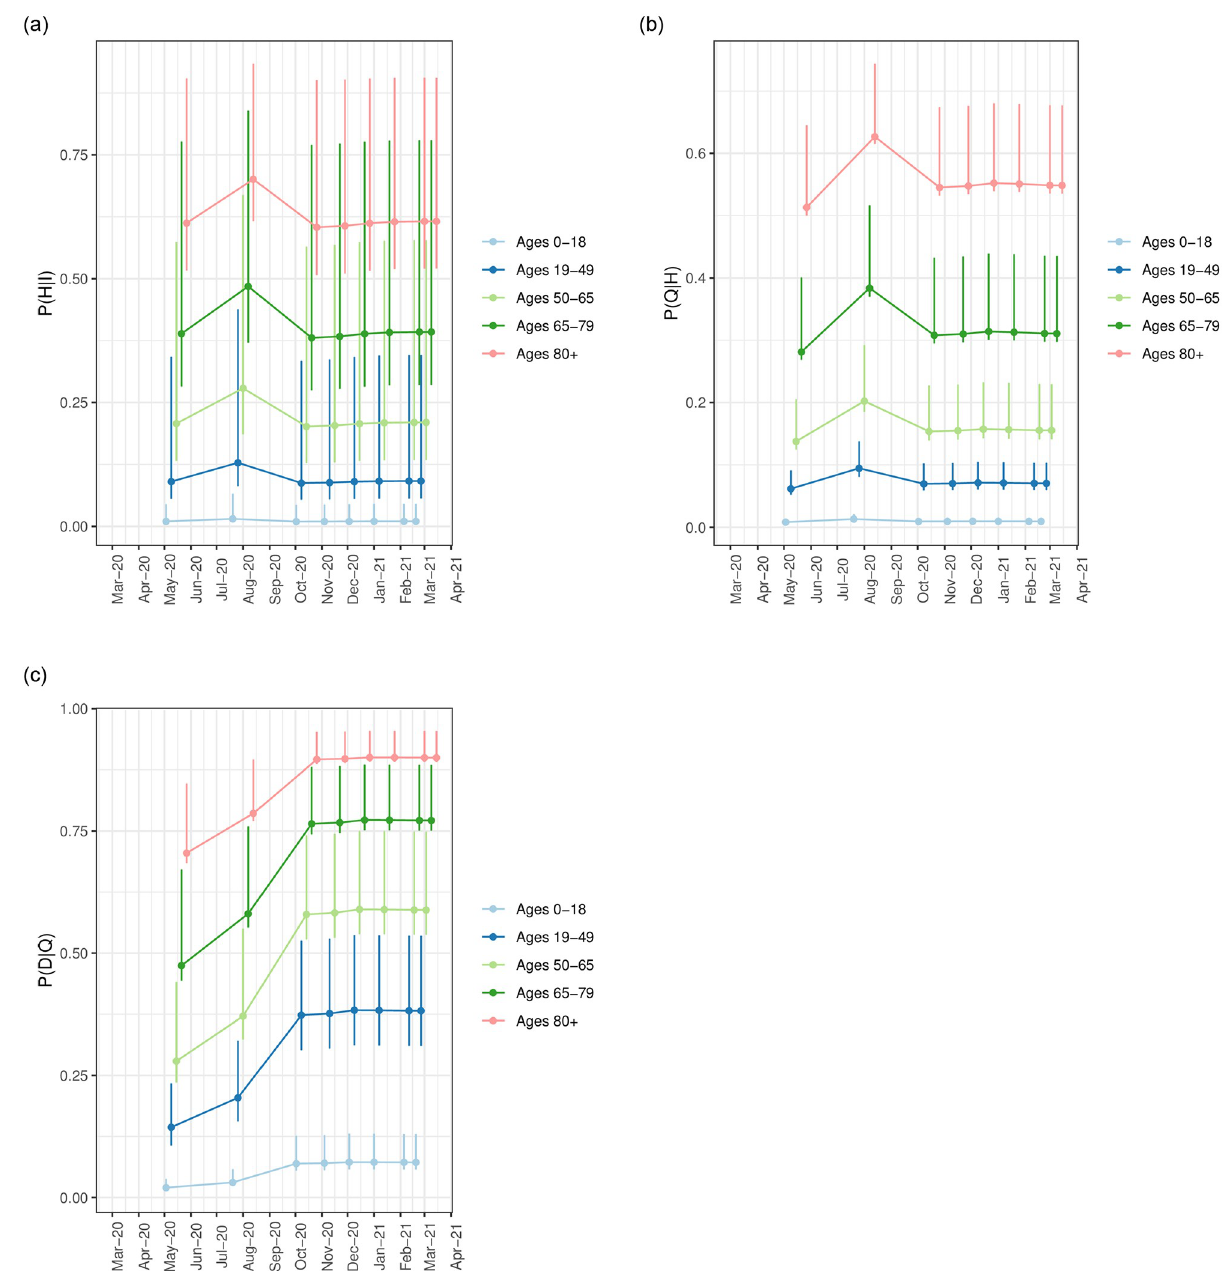
Fig 5. Range of the probabilities of hospitalization given infection across each risk profile, d P shows the mean (as a point), and minimum and maximum (error bar) probability for each age group 0 − 18, 19 − 49, 50 − 64, 65 − 79, 80+, under each risk model. ( a ) Range of the probabilities of ICU admission given hospitalization across each risk profile, d P Range of the probabilities of death given ICU admission across each risk profile, d P disease stage progression for the three models d P